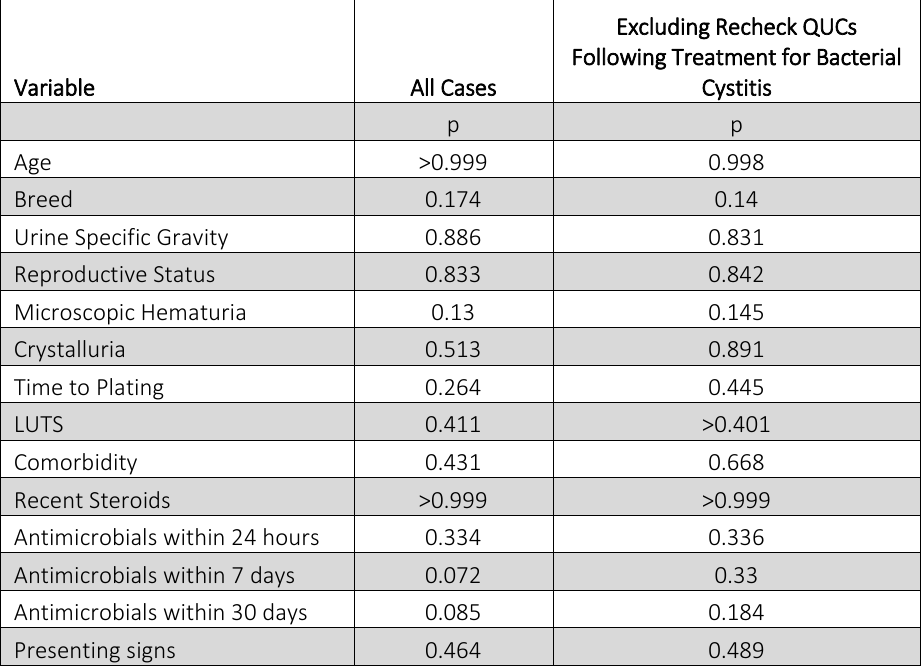
Table 2: Variable comparison between groups by means of Mann-Whitney (continuous) and Fisher's Exact Test (categorical). Values of P<0.05